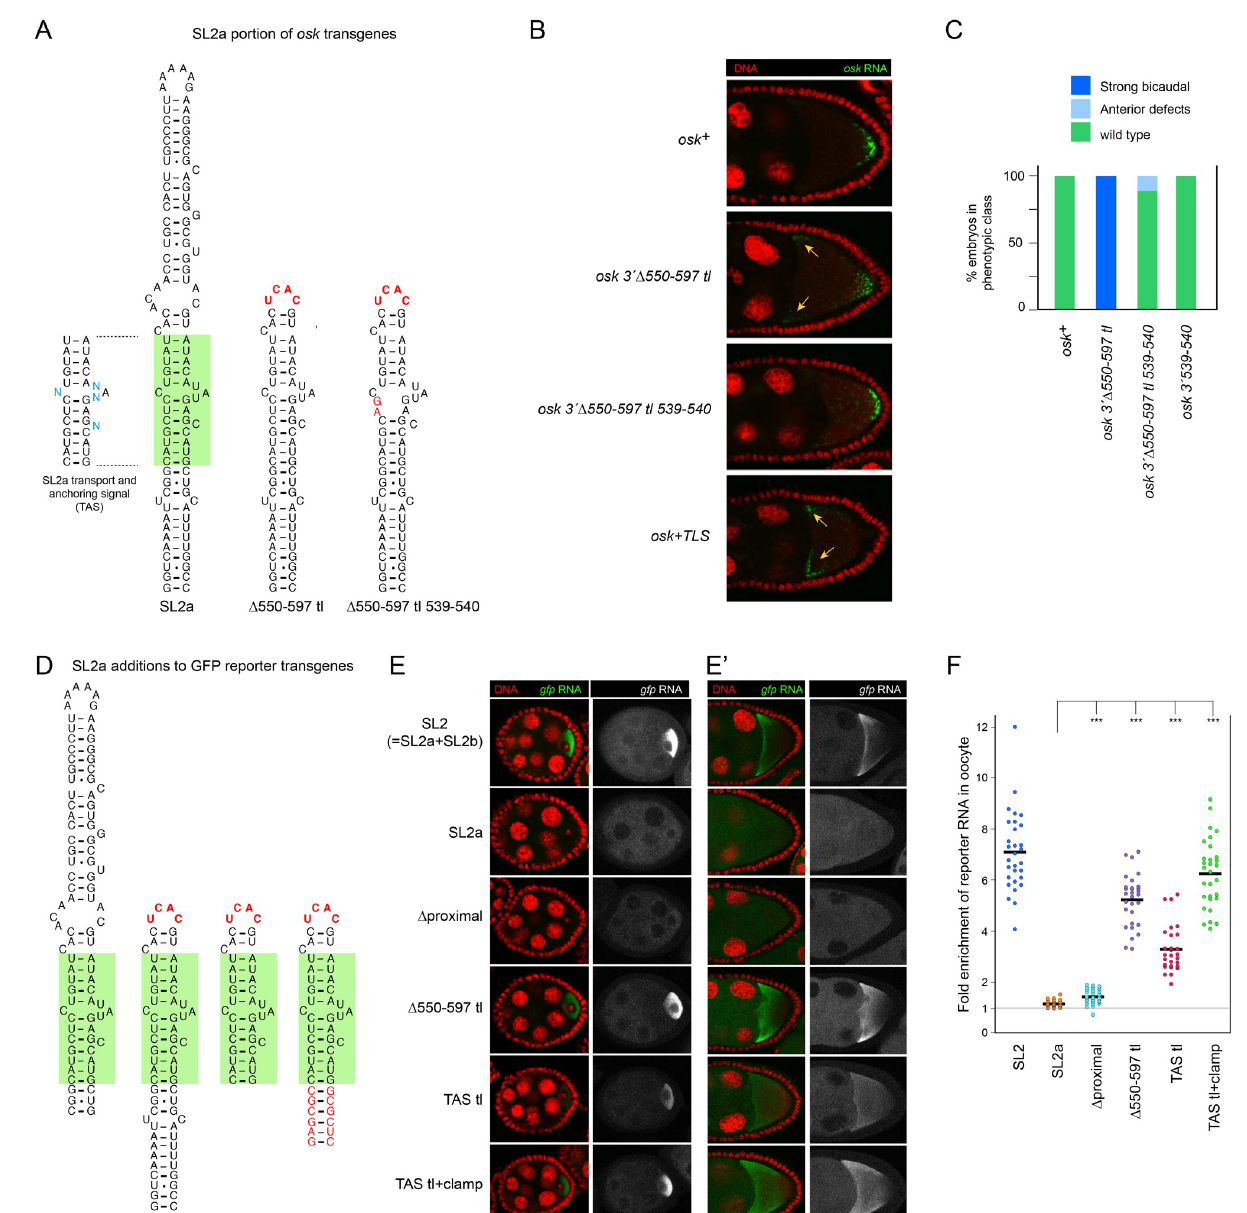
Fig 1. RNA transport and anchoring activity of SL2a and its derivatives. (A) Wild-type and mutant forms of SL2a in genomic osk transgenes. Left, the consensus transport and anchoring signal (TAS) ([11]; shaded in green here and in Fig 2), with variable positions (blue) identified by phylogenetic comparisons (S1 Fig). The remainder of the predicted SL2a structure is supported at least in part by mutational analysis and phylogenetic conservation [11]. Mutant structures are shown with altered bases and the terminal tetraloop in red. (B) Distribution of osk mRNAs, wild type or mutants from panel A, in early stage 9 egg chambers. Sites of abnormal osk mRNA enrichment for this stage are indicated with arrows (orange). All genomic osk transgenes, including those in other figures, were present as single copies in osk RNA null flies. (C) Axial patterning of embryos from mothers with osk genes as in A and B, as well as a control with just the osk 3’ 539–540 mutations. Mutant phenotypes, from mislocalized osk activity, are defined as strong bicaudal (fewer than 3 duplicated abdominal segments) or anterior defects (loss of anterior pattern elements without mirror image duplications). N values for all genotypes were greater than 300. (D) Portions of SL2a included in reporter transgenes expressed under UAS/GAL4 control. Tetraloops and a synthetic stem are in red. (E) Distribution of reporter mRNAs bearing portions of the osk mRNA 3’ UTR, including mutant versions from panel D. Left, complete stage 4–6 egg chambers, DNA in red and reporter RNA in green. Right, the green channel from the same images, with identical increase in signal intensity for all genotypes to better reveal reporter mRNA. (E’) Genotypes as in panel E for early stage 9 egg chambers. The right panel is again the green channel alone, but here with no increase in signal intensity relative to the left panel. (F) Quantitation of reporter RNA enrichment in the oocyte for reporter mRNAs tested in panel E. Enrichment was scored as average signal intensity in nurse cells divided by average signal intensity in the oocyte, presented in dot plot format. Absence of oocyte enrichment yields a value of 1, shown as a grey line across the graph. 30 egg chambers were analyzed for each genotype. Statistical significance was evaluated by one-way ANOVA with F(5,174) = 186.2, P < 8 x 10 − 68 . Normality was rejected (Bonferroni corrected Shapiro-Wilk test), therefore the Wilcoxon rank sum test was used for post hoc analysis. ��� : P < 0.01.